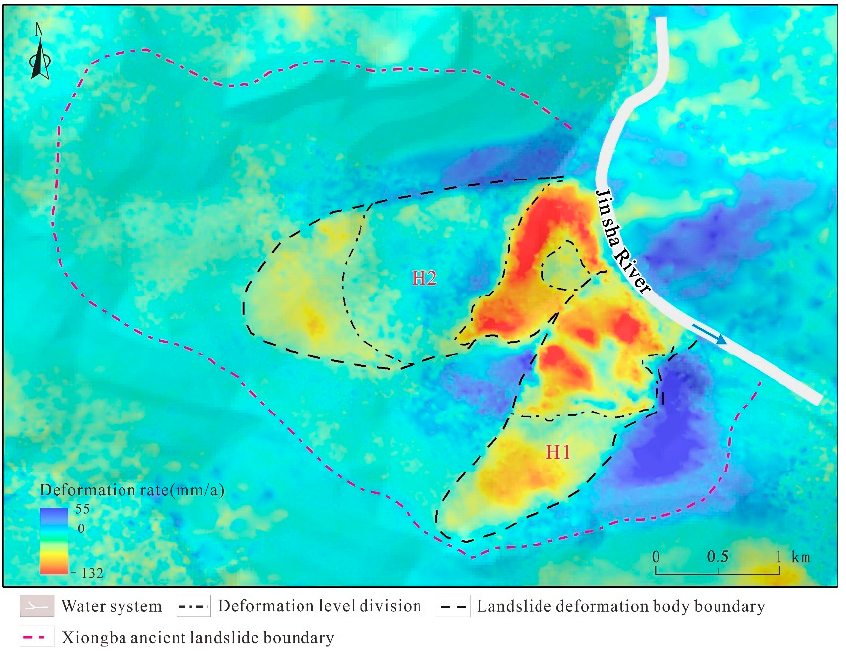
Figure 7. Deformation rate distribution map of the Xiongba ancient landslide based on SBAS-InSAR technology. The InSAR monitoring results reveal that the most serious deformation was distributed in the middle and lower parts of the landslide deposits (III 1 and III 2 ), with a deformation rate exceeding − 100 mm/a, and a maximum deformation rate of − 132 mm/a. On the basis of the InSAR surface deformation classification scheme proposed by Feng et al. (2020) [52] and the field survey in this area, we divided the deformation of the Xiongba ancient landslide into four levels, that is, the extremely strong deformation zone ( − 132 mm/a ≤ V LOS < − 59 mm/a), strong deformation zone ( − 59 mm/a ≤ V LOS < − 20 mm/a), medium deformation zone ( − 20 mm/a ≤ V LOS < 2 mm/a) and low deformation zone (2 mm/a ≤ V LOS < 55 mm/a) (Figure